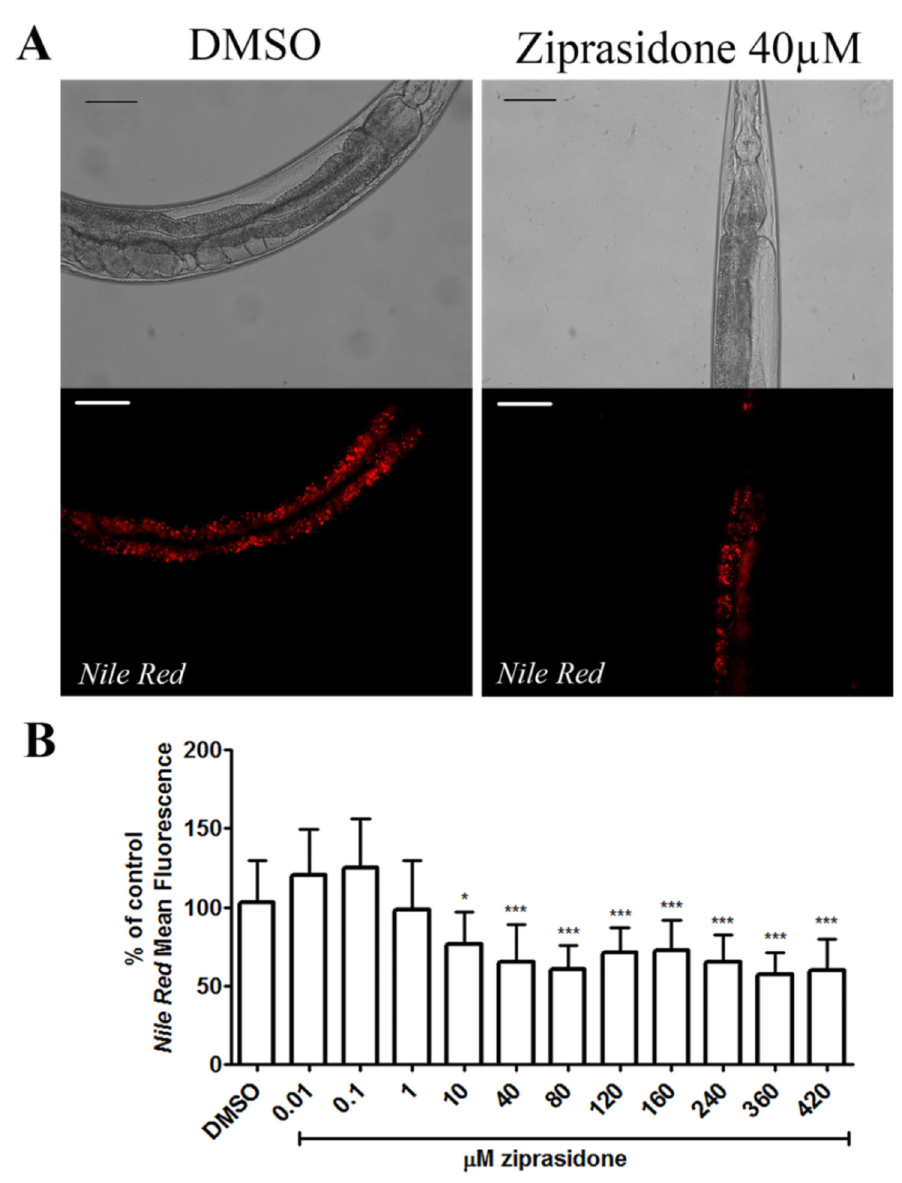
Figure 1. Nile Red Fluorescence reduction in Caenorhabditis elegans wild-type (N2) after Ziprasidone treatment for 24h. (A) Representative images of Ziprasidone treatment; (B) dose-response curve to Ziprasidone. A set of optical sections of 2.52 mm through the specimen (called a "Z series") of the first intestinal pair cells. The control group correspond to DMSO 0.16% in Acetic acid (1:10 000). The results were expressed in percentage of control (mean of fluorescence, standard deviation (SD), n>15). * p<0.05; ***p<0.0001 statistically different when compared to control 24h by one way ANOVA with Bonferroni correction for post hoc multiple